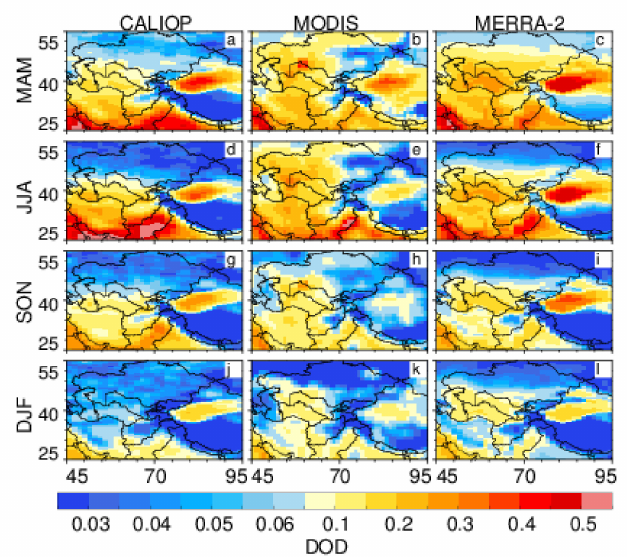
Figure 2. The seasonal climatology of DOD from CALIOP ( left ), MODIS ( middle ) and MERRA-2 ( right ) over Central Asia in ( a – c ) spring (MAM: March–April–May), ( d – f ) summer (JJA: June–July– August), ( g – i ) autumn (SON: September–October–November), and ( j – l ) winter (DJF: December–